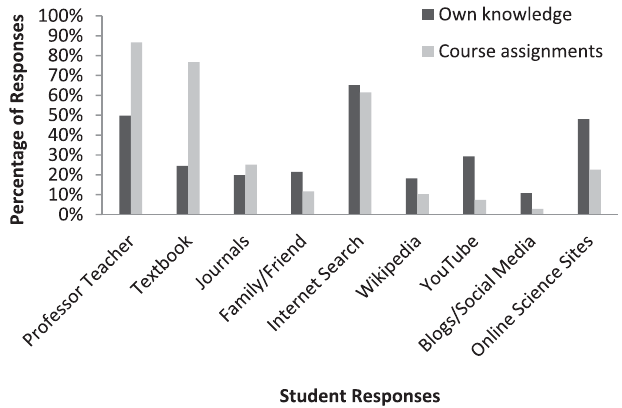
FIG. 6. Top sources where students report getting information about science.